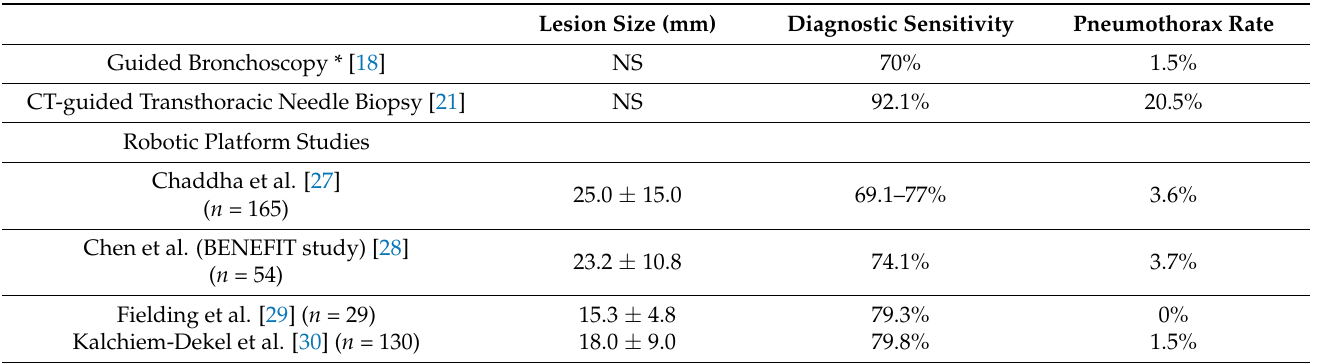
Table 1. Diagnostic sensitivity and complication rates of different